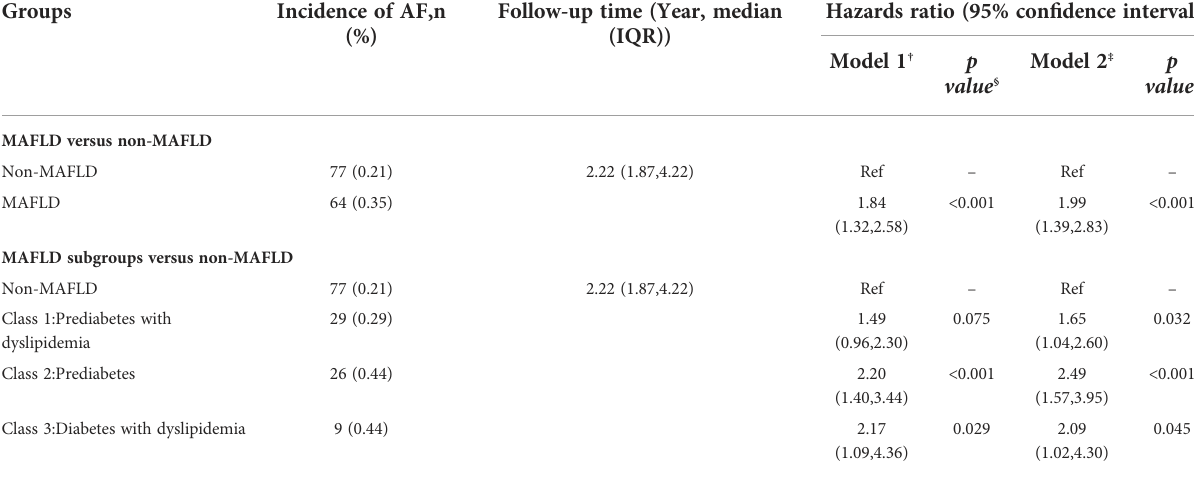
TABLE 4 The Association between Baseline MAFLD Group/Subclusters and the Incidence of Atrial Fibrillation in Longitudinal Cohort.